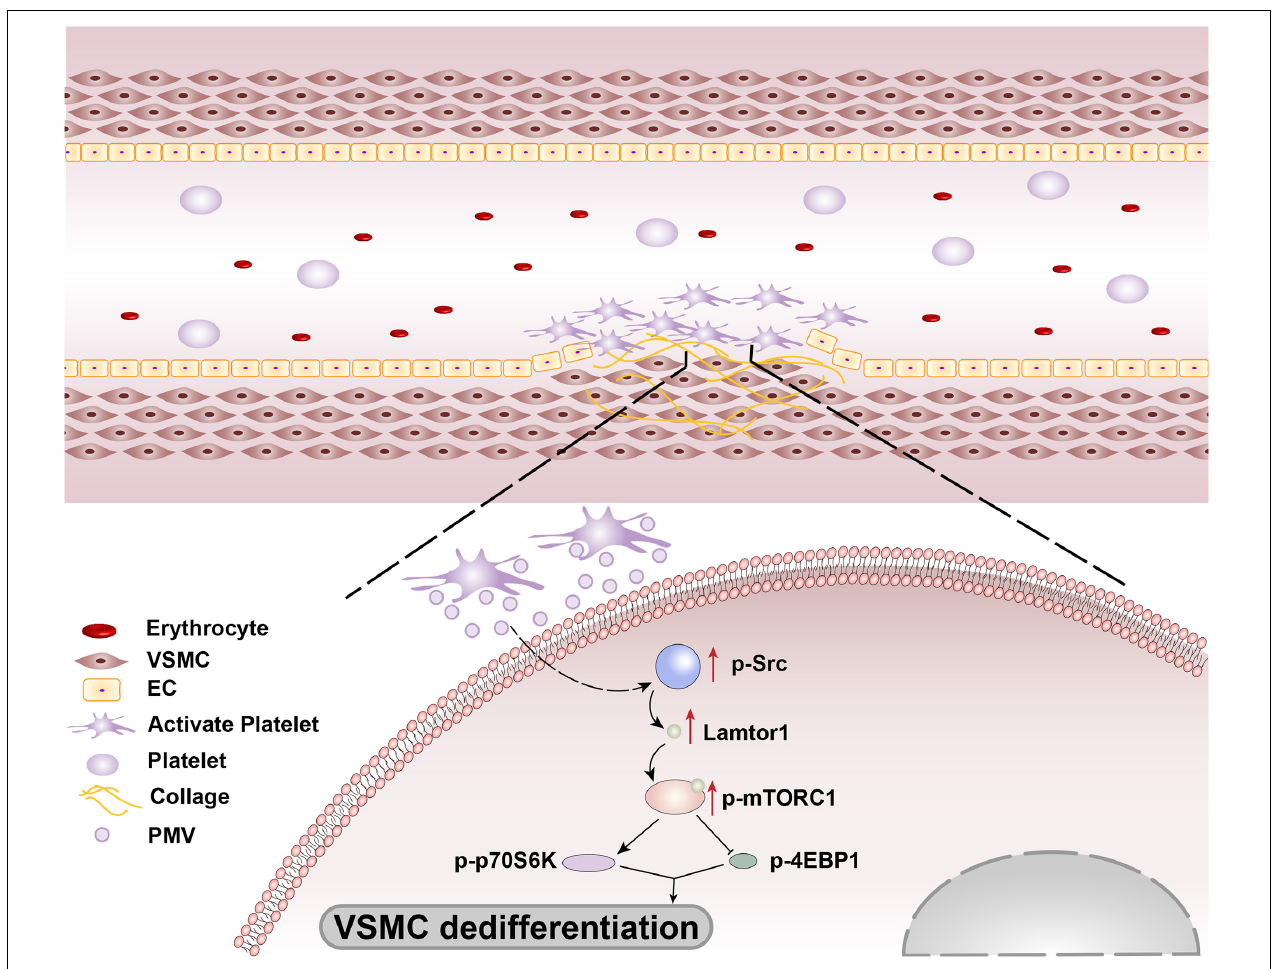
FIGURE 6 | Schematic drawing of the mechanisms of Lamtor1 in intimal hyperplasia after intimal